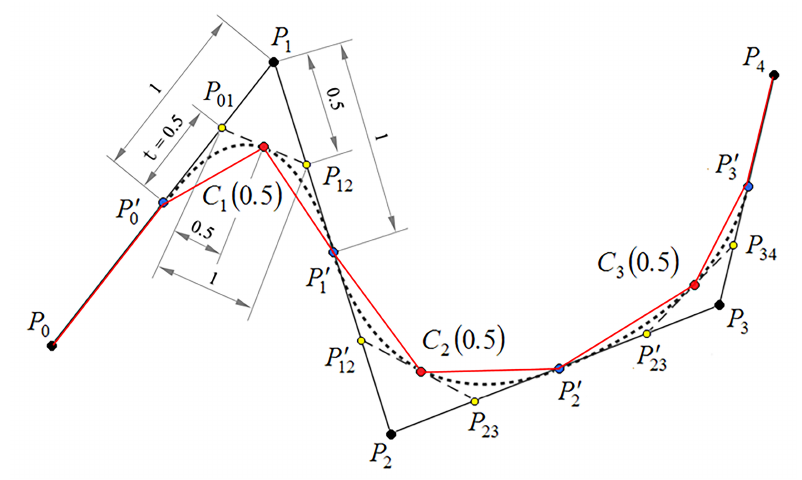
Figure 6. Schematic diagram of path